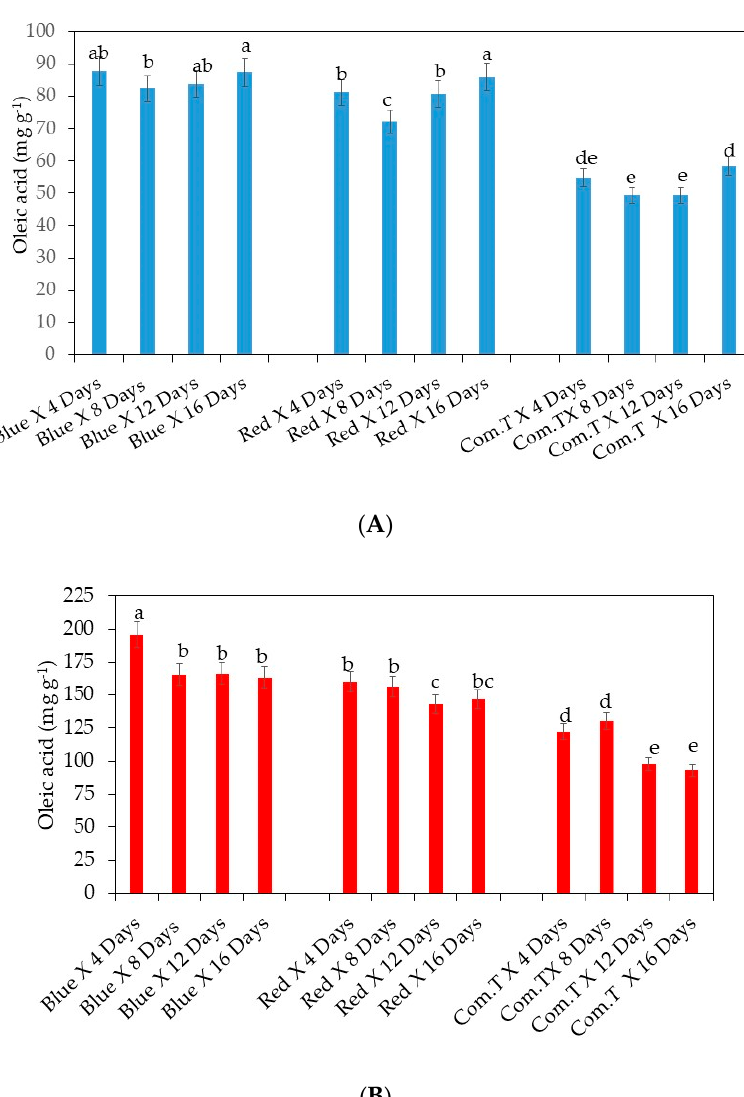
Figure 9. ( A ) Influence of LED lights on oleic acid content in the mesocarp of avocado cultivar Fuerte. ( B ) Influence of LED lights on oleic acid content in the mesocarp of avocado cultivars Hass and Fuerte. Mean ± standard deviation values for each bar were calculated based on five fruits. Number of replicates per treatment n = 5. Mean values of bars marked by di ff erent letters were significantly di ff erent at p < 0.05, according to Fisher’s protected LSD test. Blue, blue LED light; Red, red LED light; Com.T, commercial treatment.